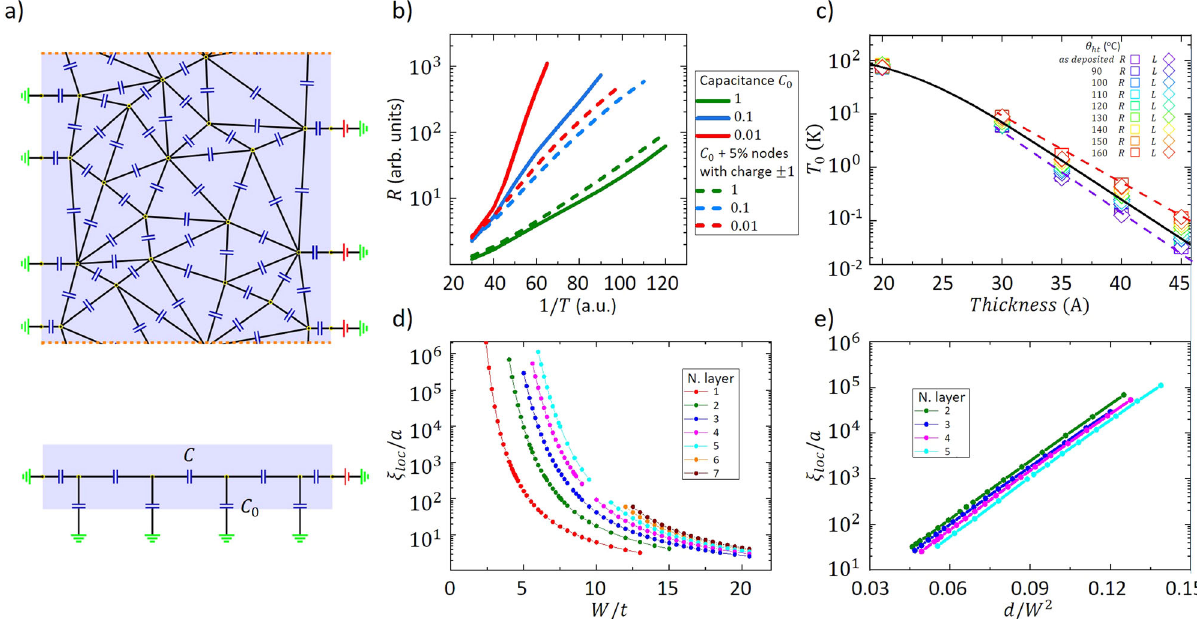
Fig. 2 Numerical simulations of the localization length and comparison with experimental data. a A sketch of the model used for numerical simulations. The electrode connected to the left edge is grounded, the electrode at the right edge has a potential V . The bottom panel shows a lateral view of the model where the capacitors C 0 connecting the system to the gate can be seen. Grains are interconnected by random capacitors with average capacitance C . b Numerical results of the resistance as a function of inverse temperature. Each color corresponds to a different value of C 0 . The solid lines correspond to the clean case whereas the dashed lines correspond to the case where disorder is added (5% of the nodes have fi xed charges ±1 at random). c Characteristic temperature T 0 as a function of the sample thickness (in Å ) for different heat treatments ( x = 13.5% sample). The solid line corresponds to Eqs. (4)-(6) with κ ≃ 250. For each thickness, the disorder level was averaged over the different heat treatments. Each dashed line corresponds to the exponential thickness 0 dependence for a given heat treatment (as-deposited and θ ht = 160 ∘ C). d Localization length on a logarithmic scale as a function of the disorder level W (relative to the kinetic energy t ) for thicknesses ranging from 1 to 7 layers. e Exponential dependence of ξ loc with d / W 2 , where d is the